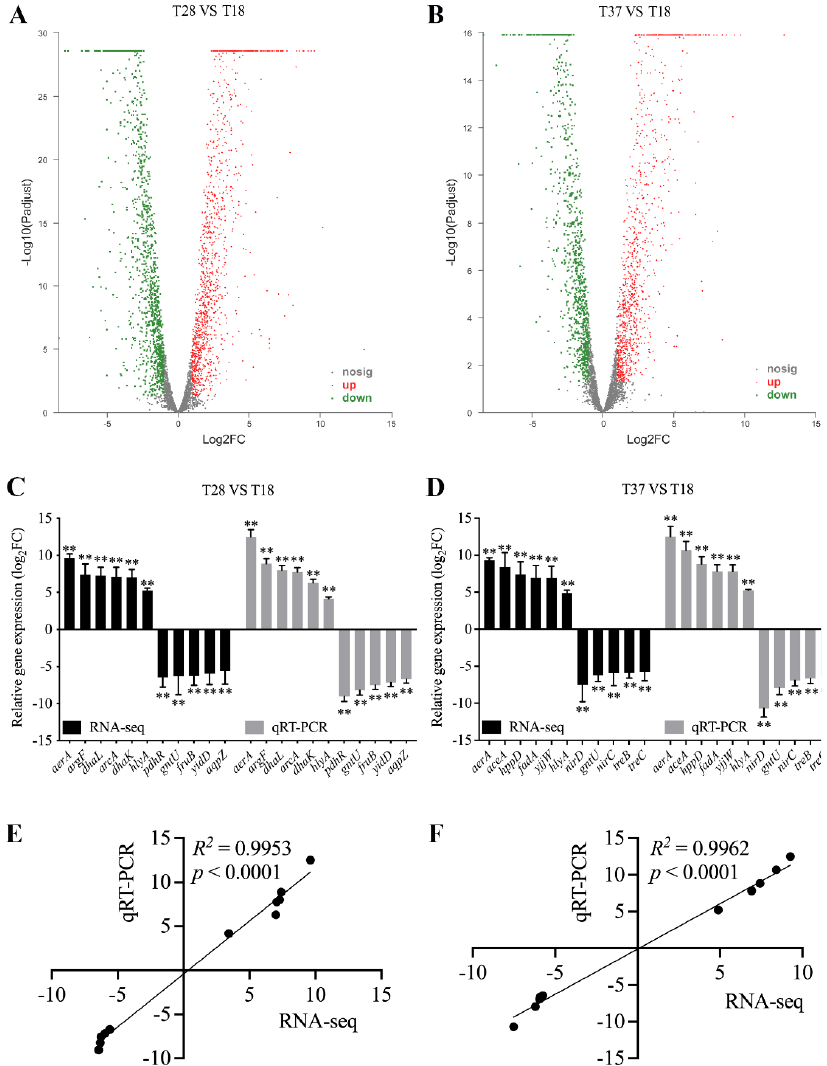
Figure 2. Validation of gene expression. ( A , B ) Volcano plot of all genes at 28 °C ( A ) and 37 °C ( B ) compared to those at 18 °C; X ‐ axis represents the fold change values, Y ‐ axis represents statistical test value. Red dots indicate genes significantly up ‐ regulated. Green dots represent genes significantly down ‐ regulated. Grey dots represent genes non ‐ significantly regulated. ( C , D ) qPCR validation of genes randomly selected at 28 °C ( C ) and 37 °C ( D ) compared to those at 18 °C. Data are presented as mean ± SD ( n = 3). ** p < 0.01 means a significant difference from the 18 °C group. ( E ) Correlation analysis of expression levels between 18 and 28 °C identified by qPCR and RNA ‐ seq. ( F ) Correlation analysis of expression levels between 18 and 37 °C identified by qPCR and RNA ‐ seq. A value of p < 0.05 is used to indicate significant correlations.